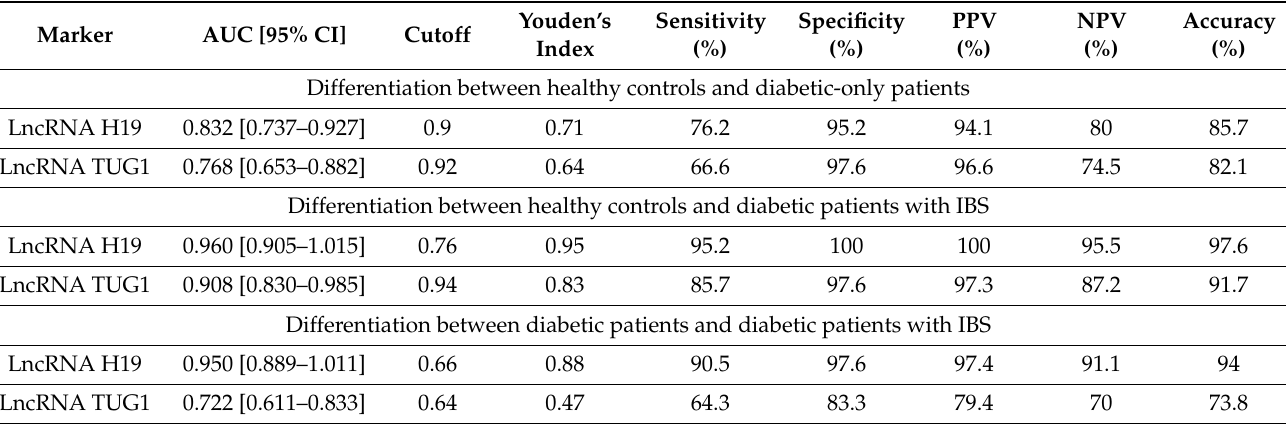
Table 3 shows that the expression of lncRNA H19 in the diabetes group correlated negatively with HbA1c, cholesterol, triglycerides, and LDL-C, whereas lncRNA TUG1 only correlated negatively with HbA1C. lncRNA H19 and TUG1 expression in diabetic patients with IBS had significant negative correlations with Table 3. Association of lncRNAs, clinical data, and laboratory data in the studied patients.